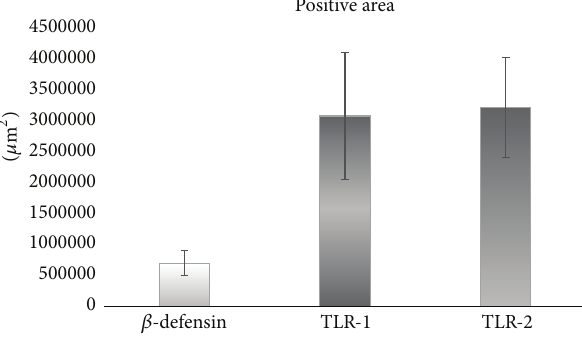
Figure 3: Morphometric analysis of the liver biopsies. The average ± standard error in the quantification of positive areas in the liver biopsies of patients with bile duct injuries subjected to biliary- digestive reconstruction can be obtained. The higher expression of TLR-1 and TLR-2 than 𝛽 -defensin can be appreciated, which suggests deregulation between the innate and adaptive immune responses when faced with infection of the bile